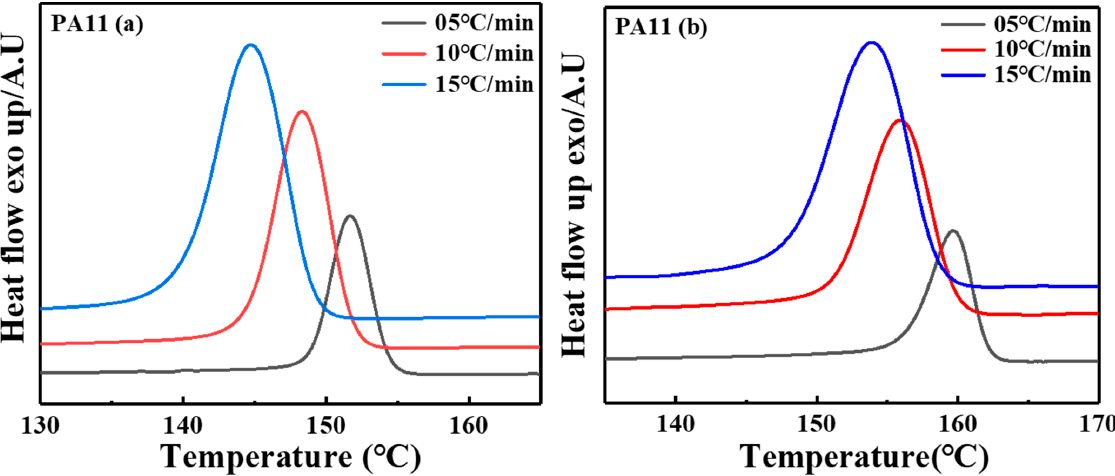
Figure 2. The DSC cooling curves of non-isothermal crystallization for two PA11 specimens at different cooling rates. Table 1. Non-isothermal crystallization values of two PA11 at varying cooling rates.